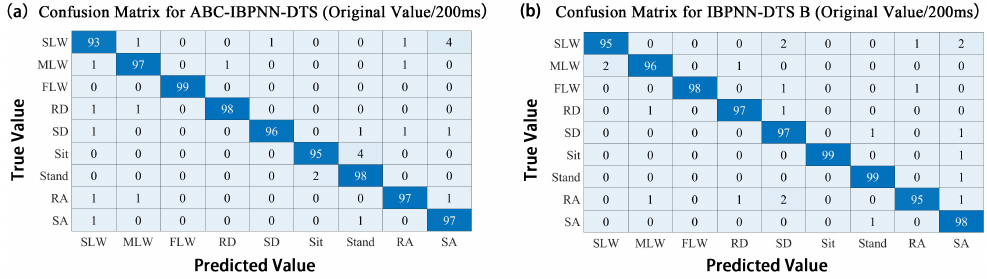
Figure 10. Confusion matrix for IBPNN-DTS B models before and after optimization (all values are